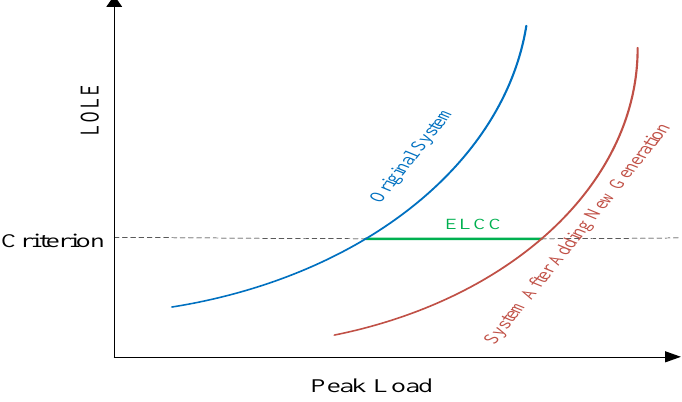
Figure 3. Evaluation of effective load carrying capability (ELCC).